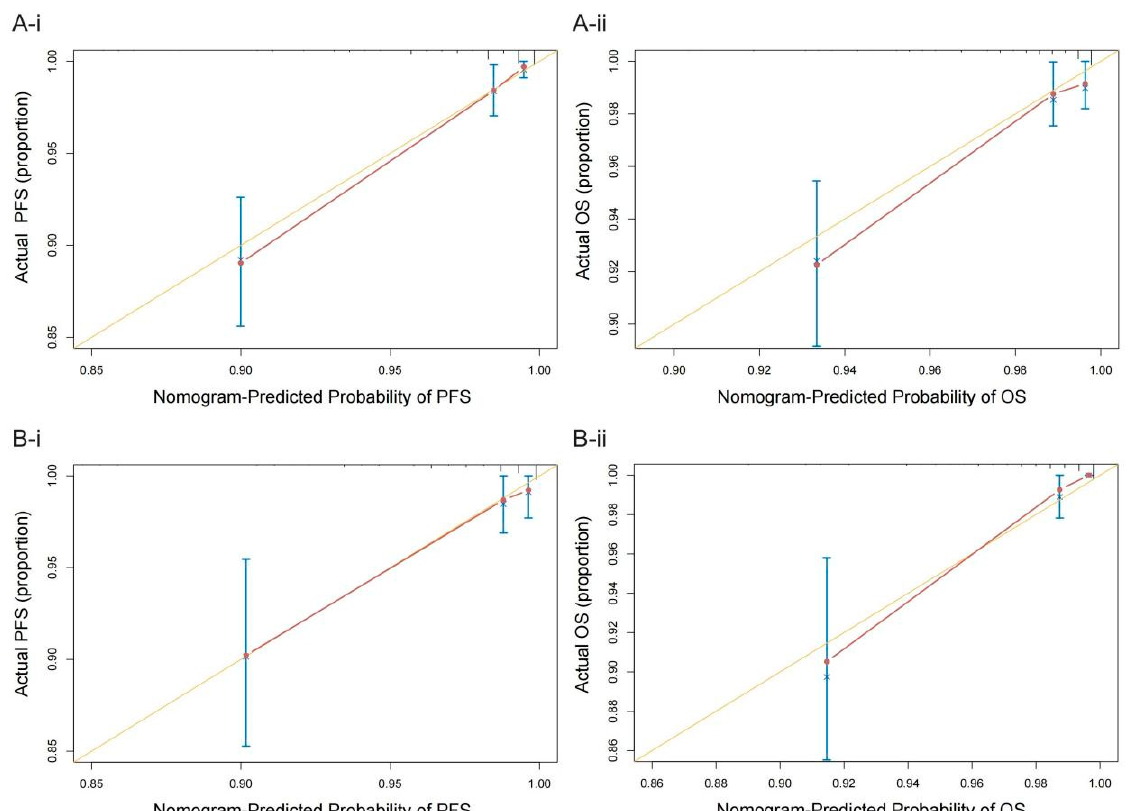
Figure 4. Calibration plots of the nomograms of PFS ( A-i ) and OS ( A-ii ) in the training cohort and the nomograms of PFS ( B-i ) and OS ( B-ii ) in the validation cohort. The yellow line represents the performance of the ideal nomogram; the red line represents the performance of the proposed nomogram; the red circles represent the sub-cohorts of the dataset; × is the bootstrap-corrected estimate of the nomogram; and the error bars represent the 95% CI.